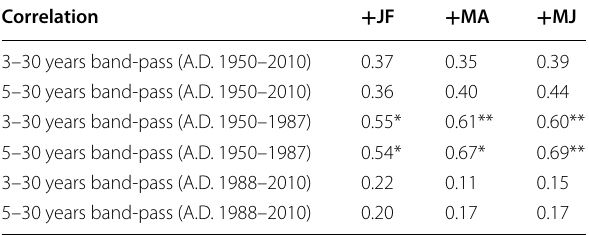
Table 2 Correlation coefficients between tree-ring δ 18 O and NPGO index after band-pass filtration